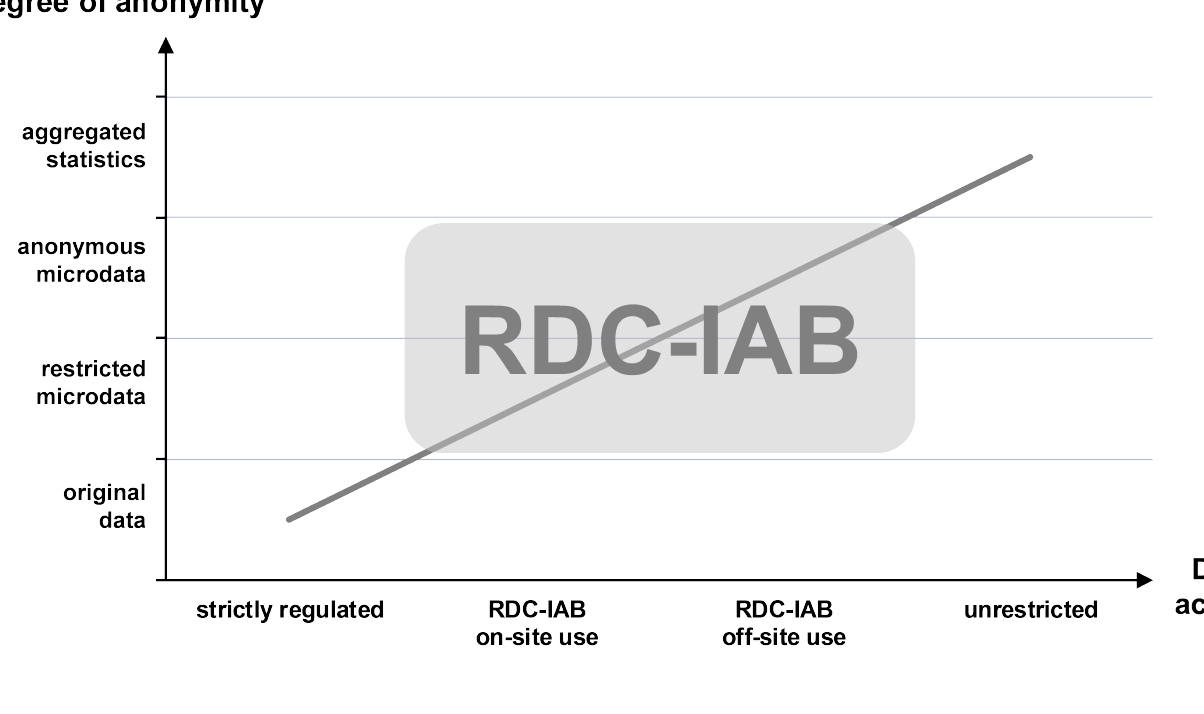
Figure 2: Relationship of degree of anonymity and data access